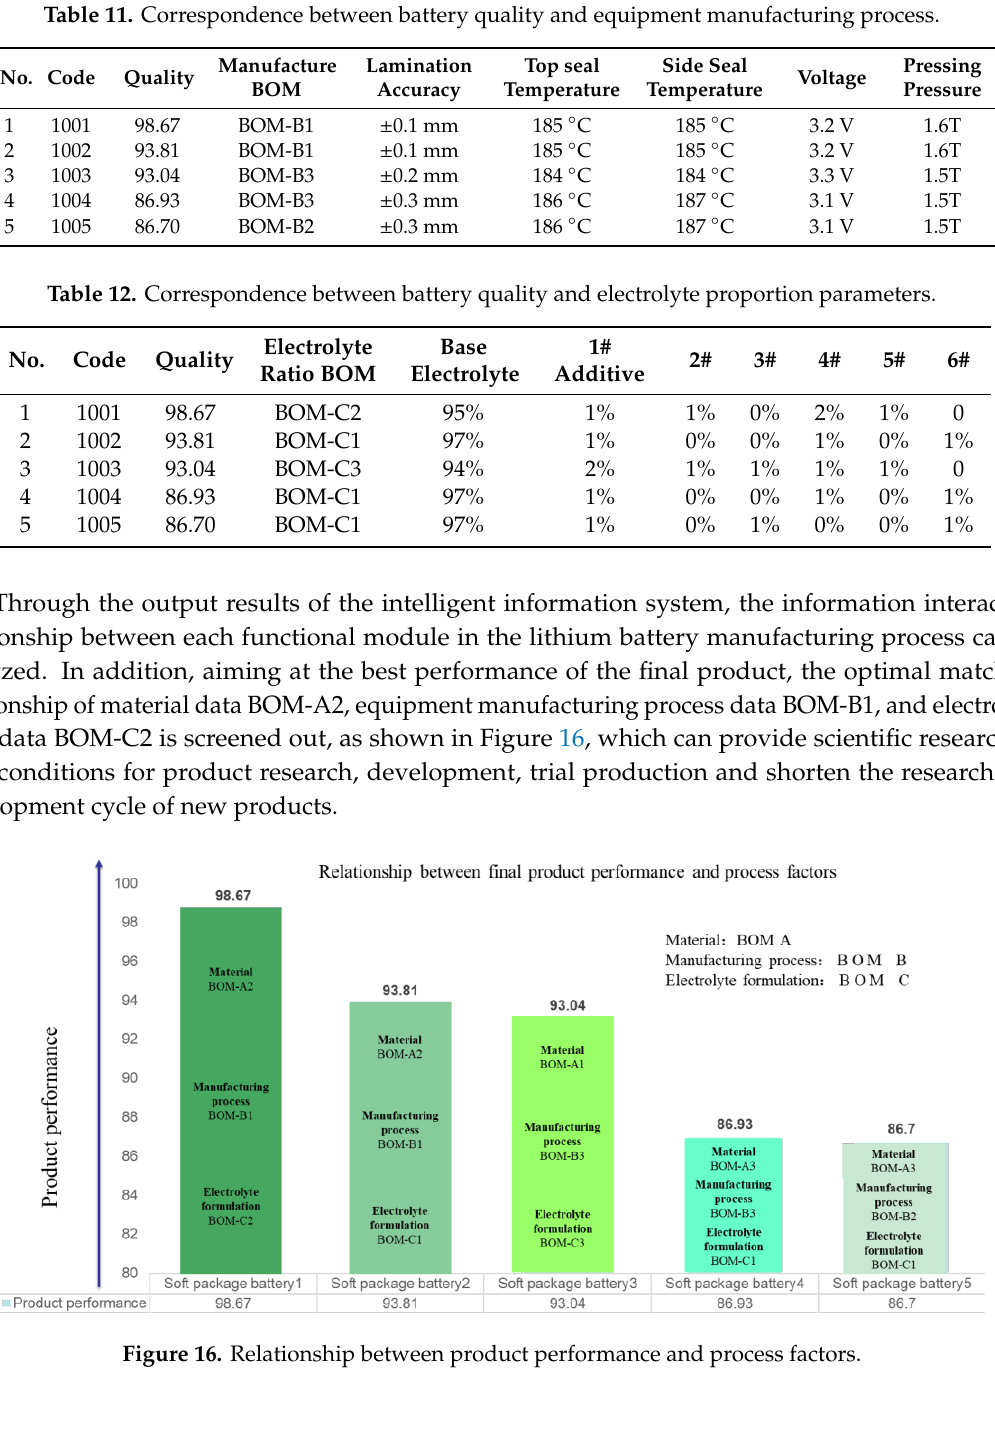
Table 10. Correspondence between battery quality and material information.